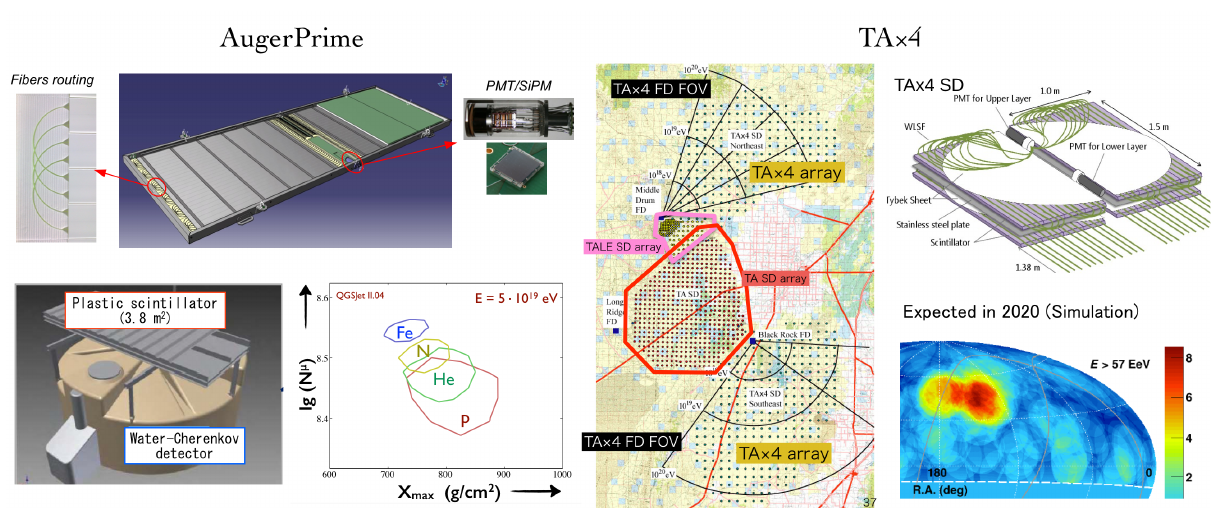
4 (right)[20]. AugerPrime will provide excellent sensitivity to the mass ×